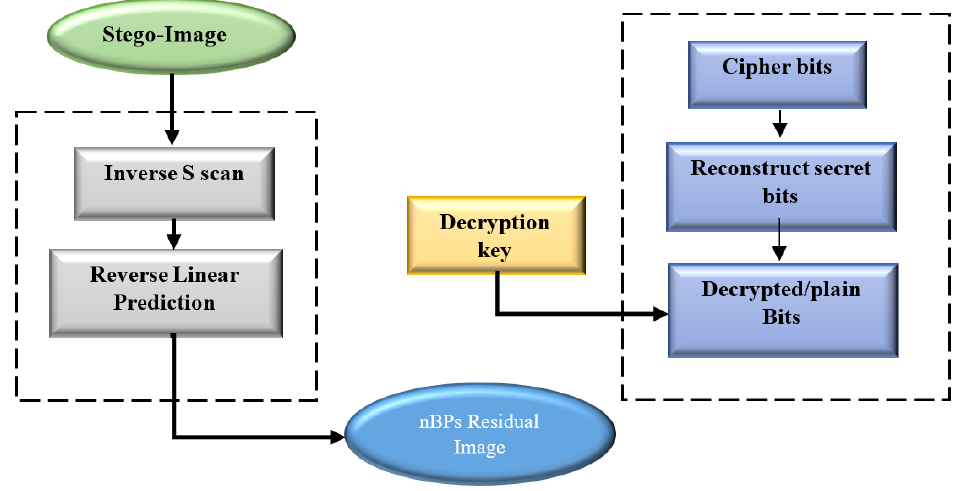
Figure 6. Flowchart of the Extraction Procedure.